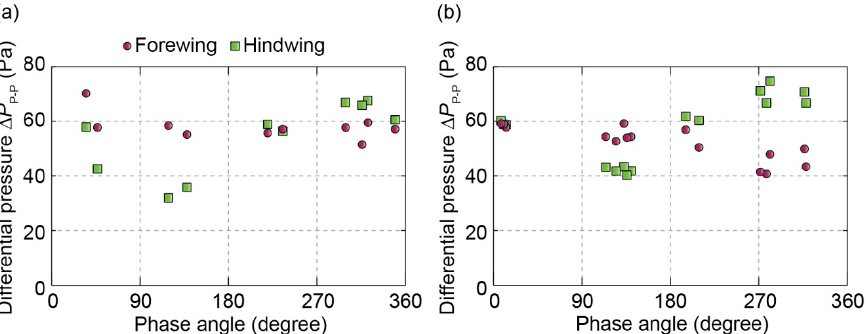
Figure 12. Relationship between the phase angle and peak-to-peak value of the differential pressure during one stroke ( a ) in the tethered condition and ( b ) in free-flight.